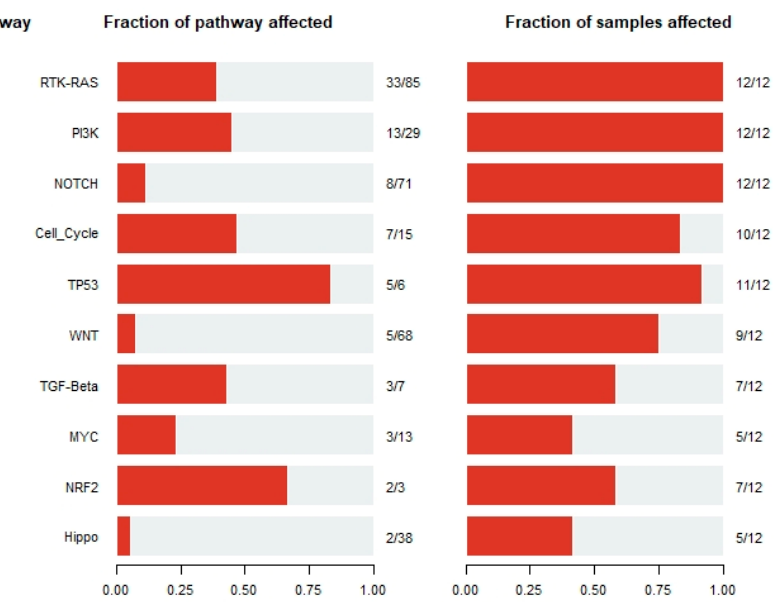
Figure 4. Most affected pathways across B-ALL samples.